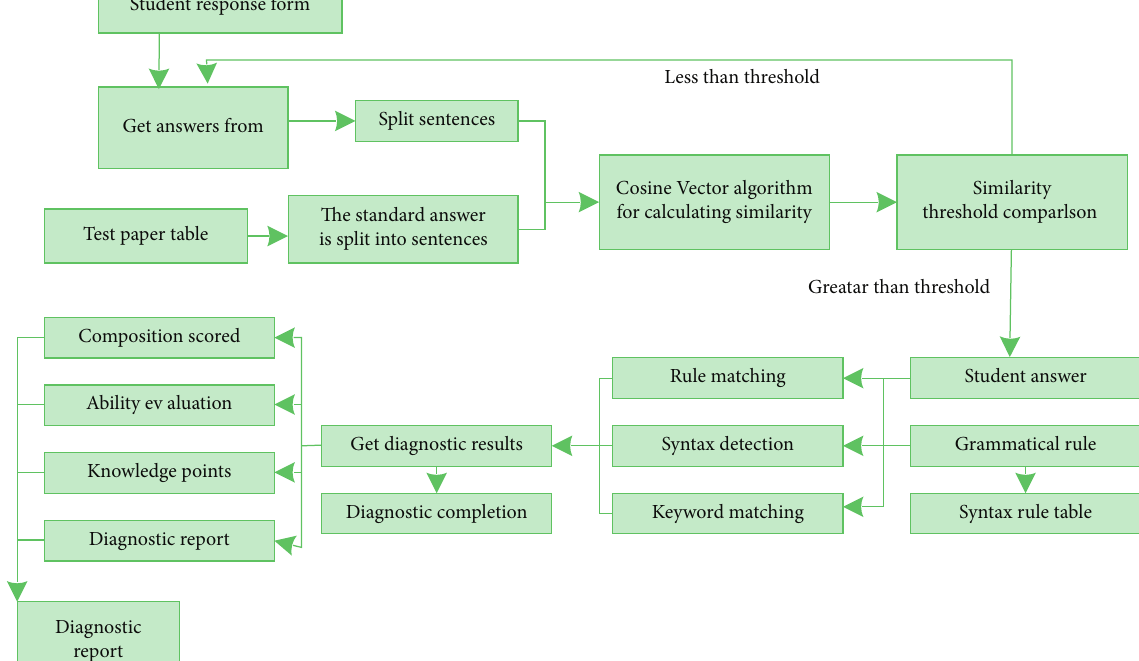
Figure 4: Activity diagram of English grammar evaluation based on dynamic programming